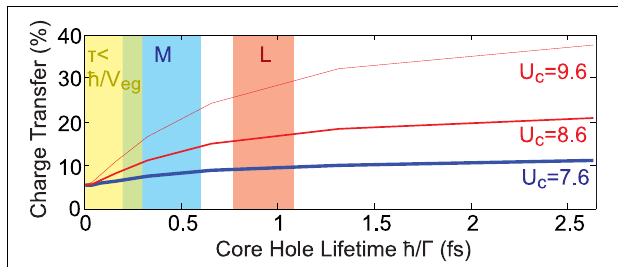
FIGURE 4 | Core shake-up and charge transfer. The intensity of core hole shake-up excitations is simulated as a percentage of total RIXS intensity from 0 to 8eV energy loss, using the SIAM model. Each plotted point is derived from a calculation in which all intermediate state lifetimes are set to the value indicated on the horizontal axis. The thick blue curve represents a parameter set thought to accurately describe the M-edge of NiO, and red curves use larger core hole